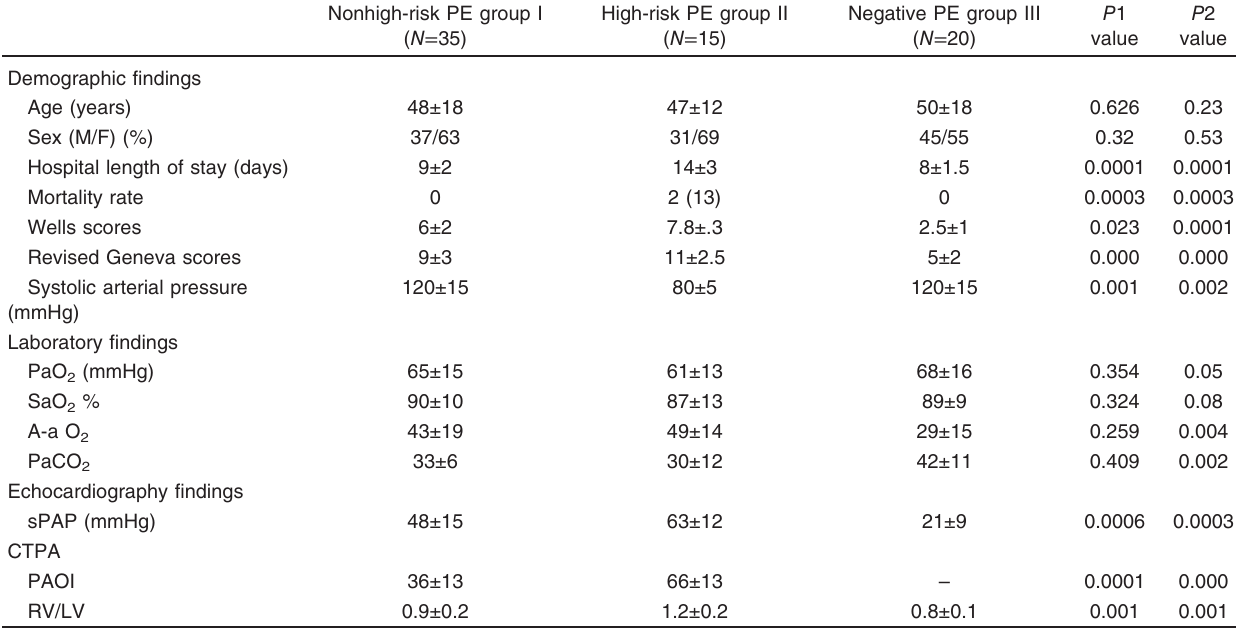
Table 1 Comparison between high-risk and nonhigh-risk groups, demographic data, hospital length of stay, laboratory data, pulmonary artery obstructive index, and echocardiography Nonhigh-risk PE group I ( N = 35)